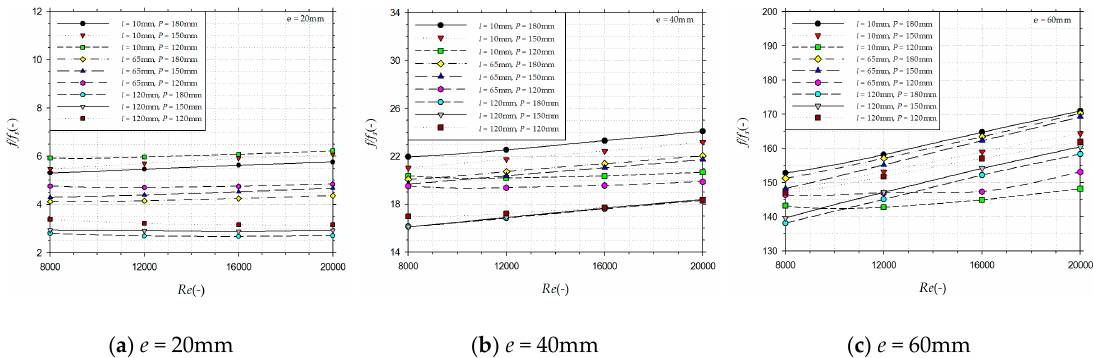
Figure 13. Enhancement in friction factor for different value of pitch ( P ), length ( l ), and for a fixed value of height ( e ) with Reynolds number.